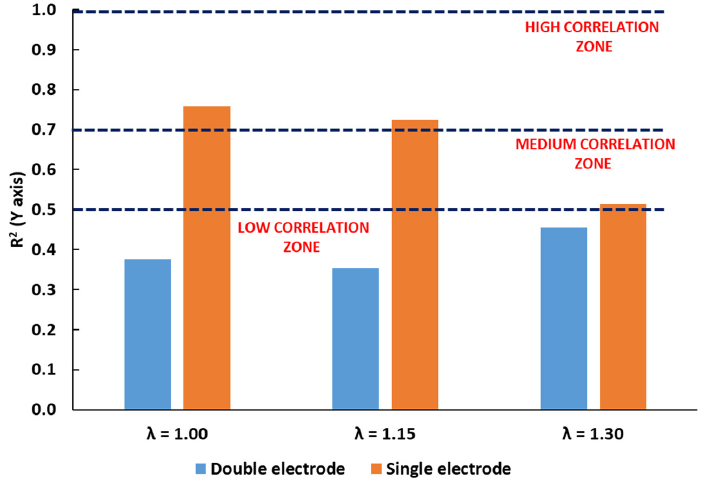
Figure 6. Coefficient of determination R 2 of the linear fit between kernel position and flame displacement at CA5 for cross-flow orientation, different AFR rel values, and fixed spark advance (12 CA).